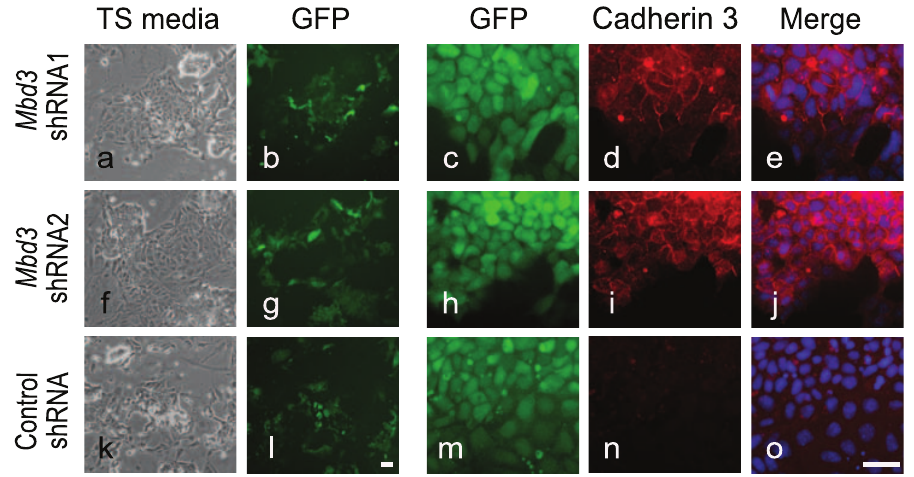
Figure 6. Reduction of Mbd3 expression in mouse ES cells promotes trophectoderm stem (TS) cell derivation. Mouse ES cells transfected with contro or Mbd3 shRNAs for three days were cultured in trophoblast stem cell medium to promote differentiation into TS cells. GFP expression was used to monitor shRNA plasmids transfection (b, c, g, h, l, and m). Hoechst stains the cell nuclei. Red fluorescence shown on cell boundaries indicates the expression of cadherin 3, a surface antigen specific to trophoblast cells (d, e, i, j). Scale bars: l, 50 m m (also applies to a, b, f, g, k); o, 50 m m (also applies to c–e, h–j,